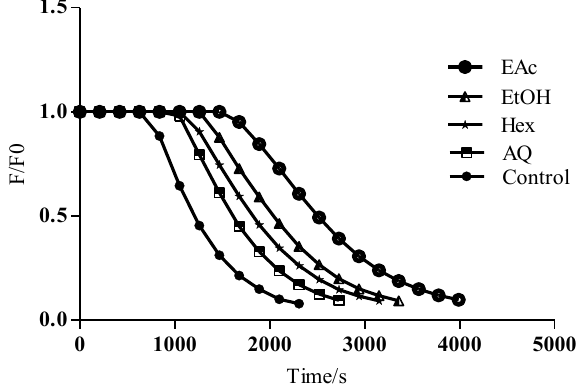
Figure 3. Kinetic profiles of fluorescein consumption in the presence and absence of M. arboreus extracts and its fractions. Fluorescein (70 nM) was incubated in the presence of AAPH (10 mM) and different amounts of a M. arboreus as described in Materials and